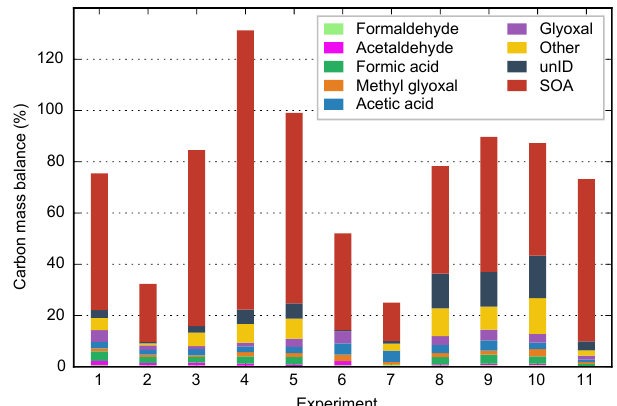
Figure 17. Carbon mass balance for each